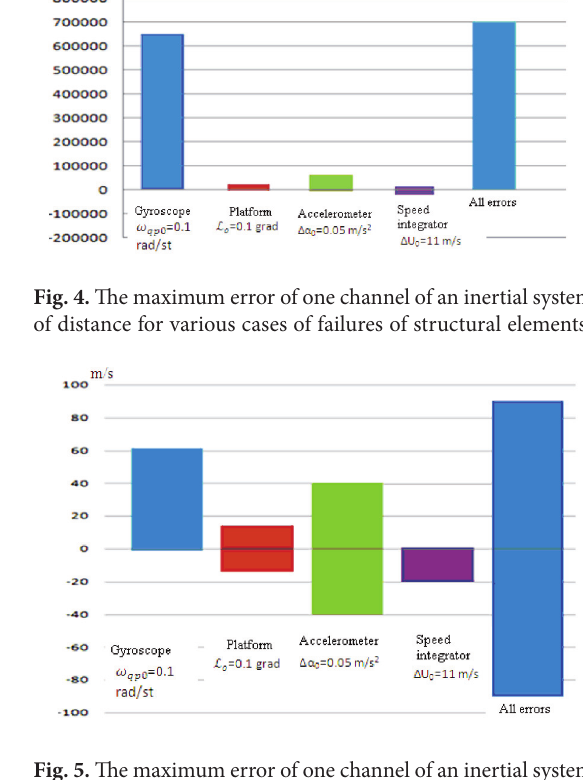
Fig. 2. The time variation in the error rate of one channel when the gyro drifts with angular velocity ω_qp0 = 0.1 grad/st